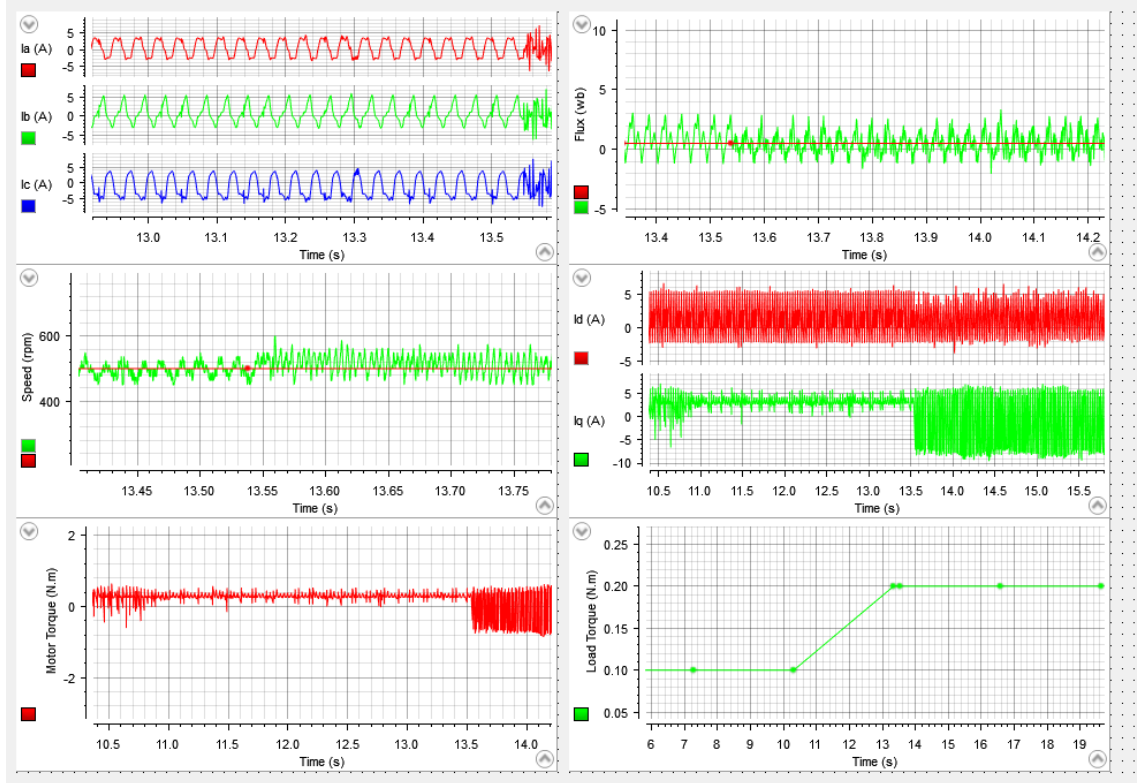
Figure 12. The PMSM performance at load